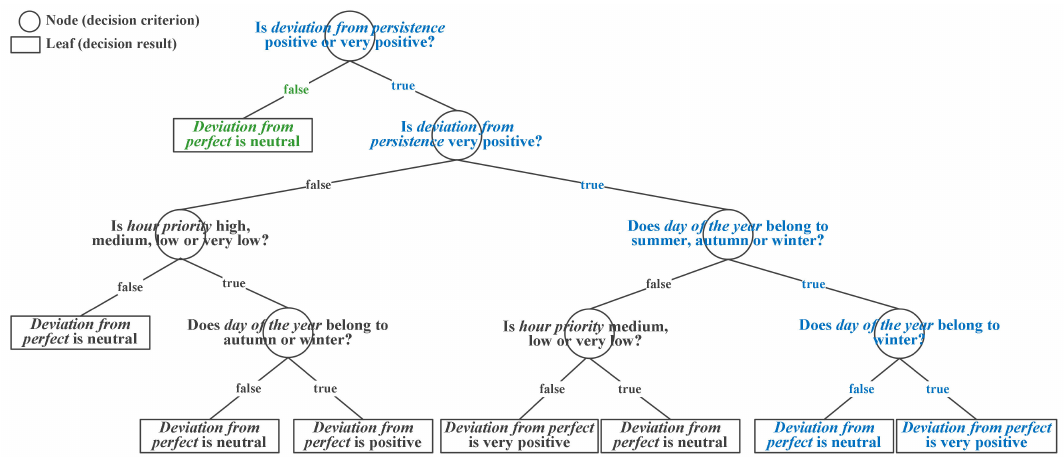
Figure 5. Final decision tree for the CSP plant application. In green, the branch used as an example for the pruning process, outlined in Figure 6. In blue, the branches used as example for the rules extraction